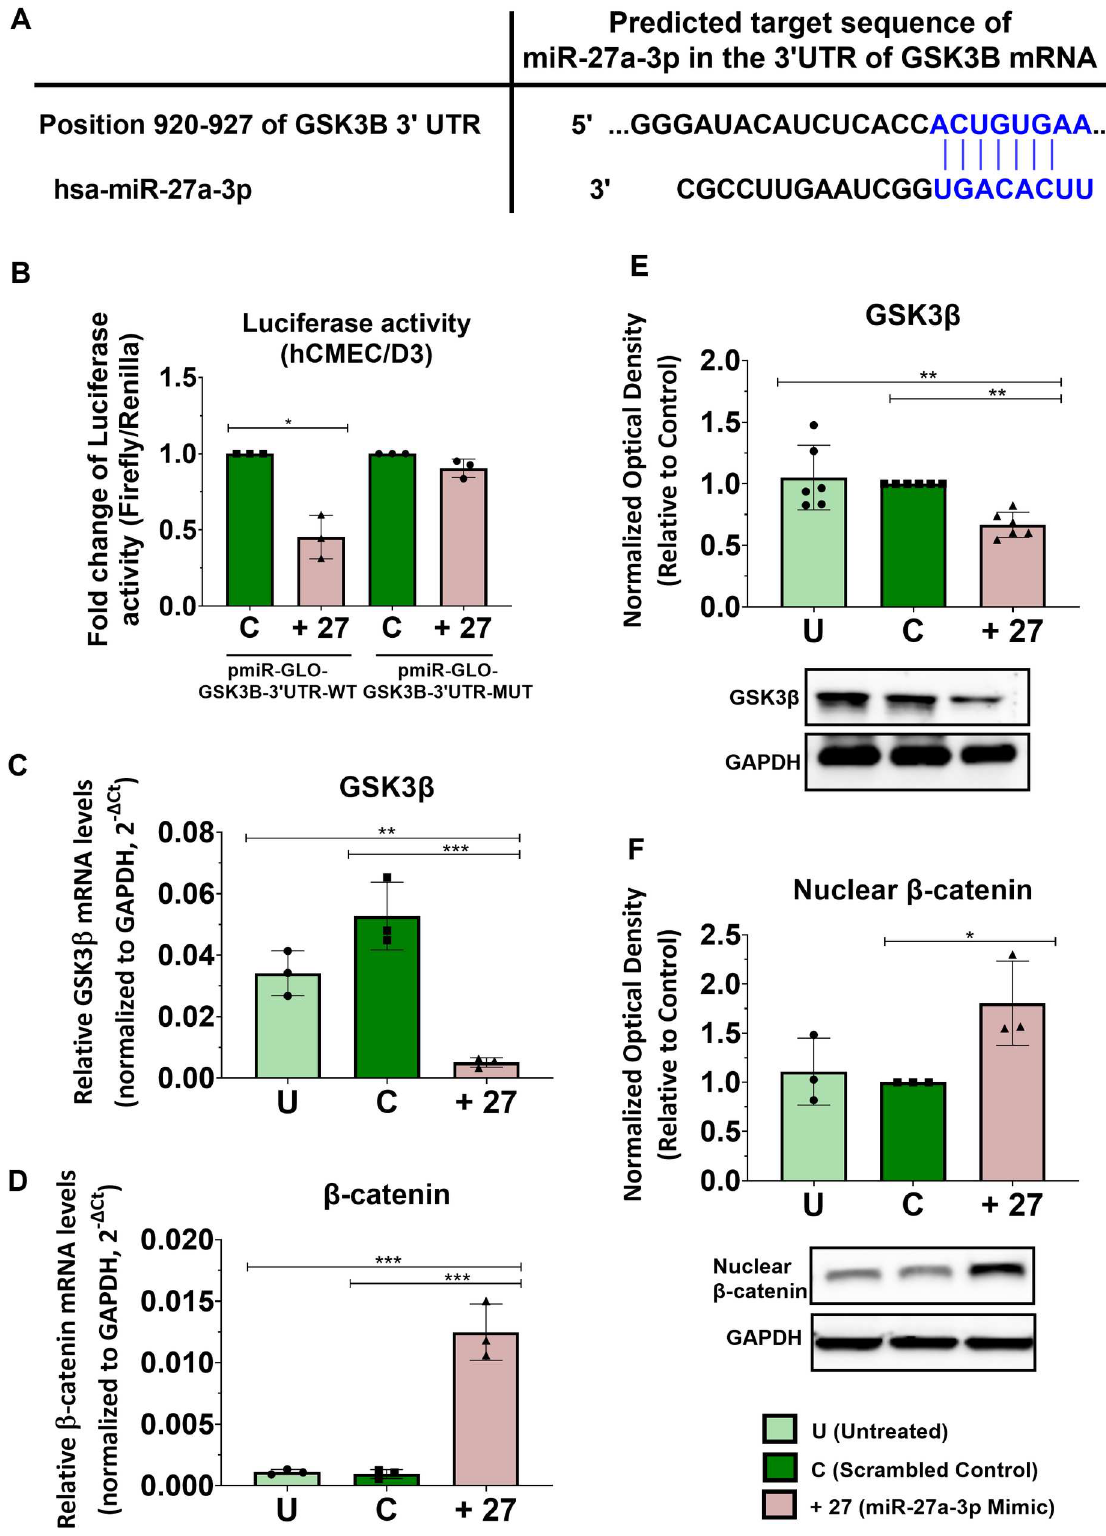
Fig 3. miR-27a-3p regulates claudin-5 and occludin expression by targeting GSK3ß and upregulating Wnt/ß-catenin. (A) Schematic representation of the GSK3ß 3’-UTR with the miR-27a-3p binding site. Complementary sequences are represented in blue. (B) Effect